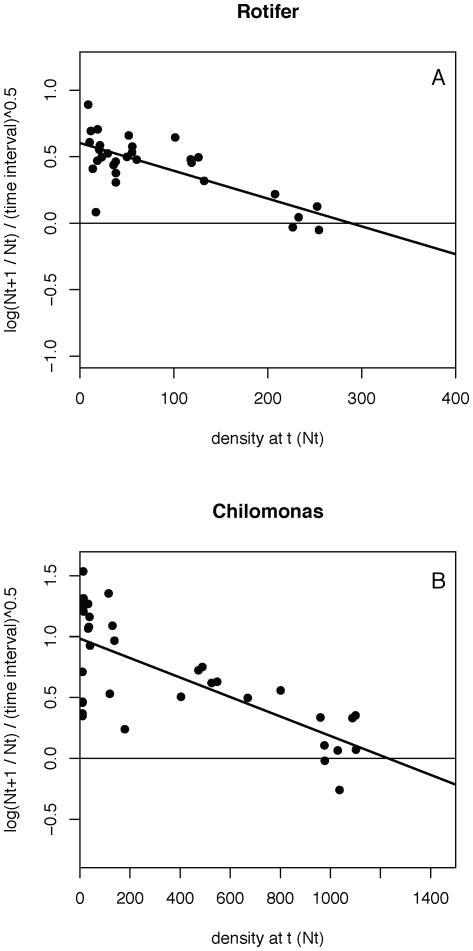
Relationship between population size and growth rate for Chilomonas sp. (A) and the rotifer species (B).Black points show growth rates from 5 replicates each at high nutrients microcosms as generally used in our study. Lines show the best fit estimates derived for r and K. Although we show all points, r and K were determined separately for each microcosm and then averaged to generate the best fit line.